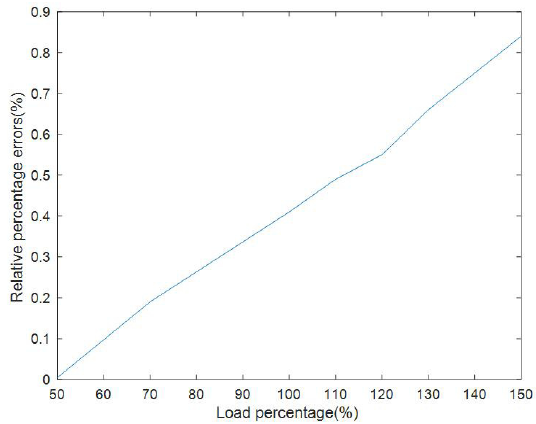
Figure 7. Relationship between voltage error and DG